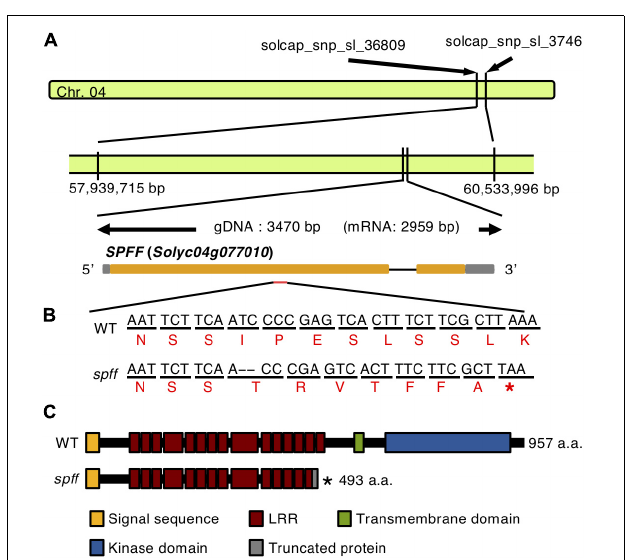
FIGURE 6 | Gene structure of Solyc04g077010. (A) The location and gene structure of Solyc04g077010. Chromosome 4 is indicated by the green bar. The gray boxes indicate the untranslated regions, orange boxes indicate the exons, separated by the introns. (B) Nucleotide and amino acid sequences of the WT and the spff mutant around the mutation point. The upper black letters indicate nucleotides, and the lower red letters indicate putative amino acids. The 2 bp deletion indicated by hyphens introduces a premature stop codon in the first exon in the spff mutant. (C) The putative amino acid length and domain structure of the RLK encoded by Solyc04g077010 , in WT and the spff mutant. In B , C ∗ indicate the stop